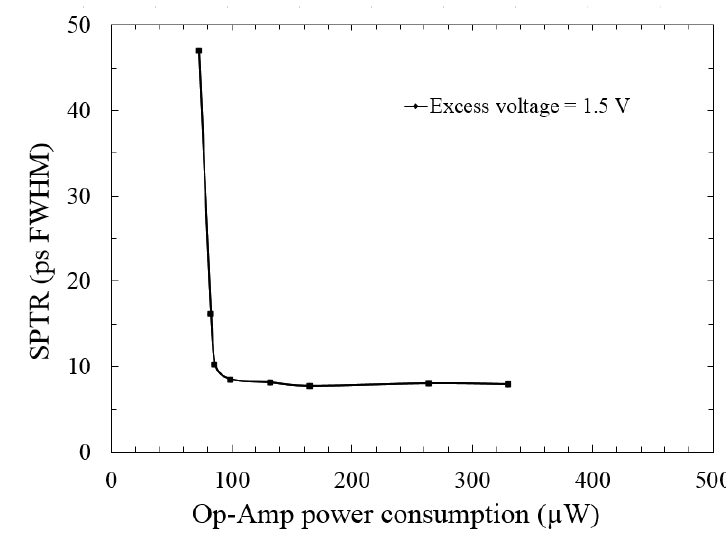
Figure 13. SPTR as a function of the QC Op-Amp power consumption.